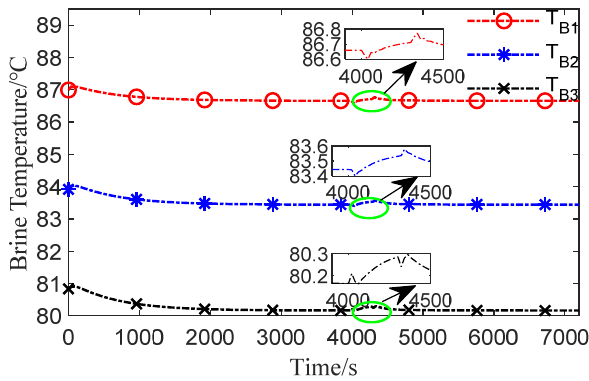
Figure 19. Dynamic of BBT for step increase in